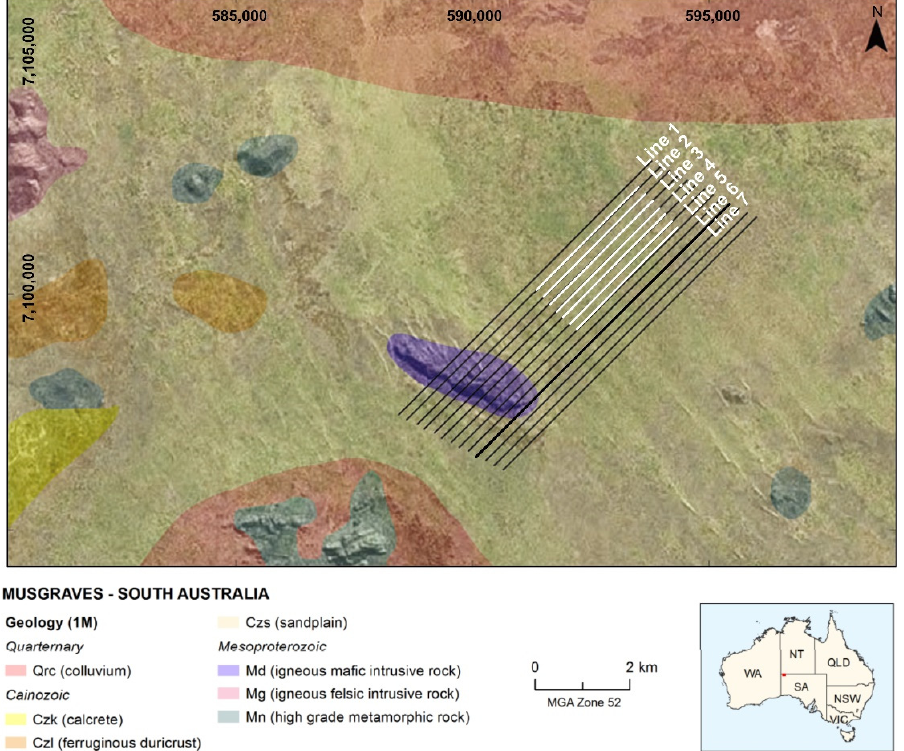
Figure 11. Flight lines in Musgraves of South Australia. The TD AEM data are acquired by the VTEM system (modified from [38]).